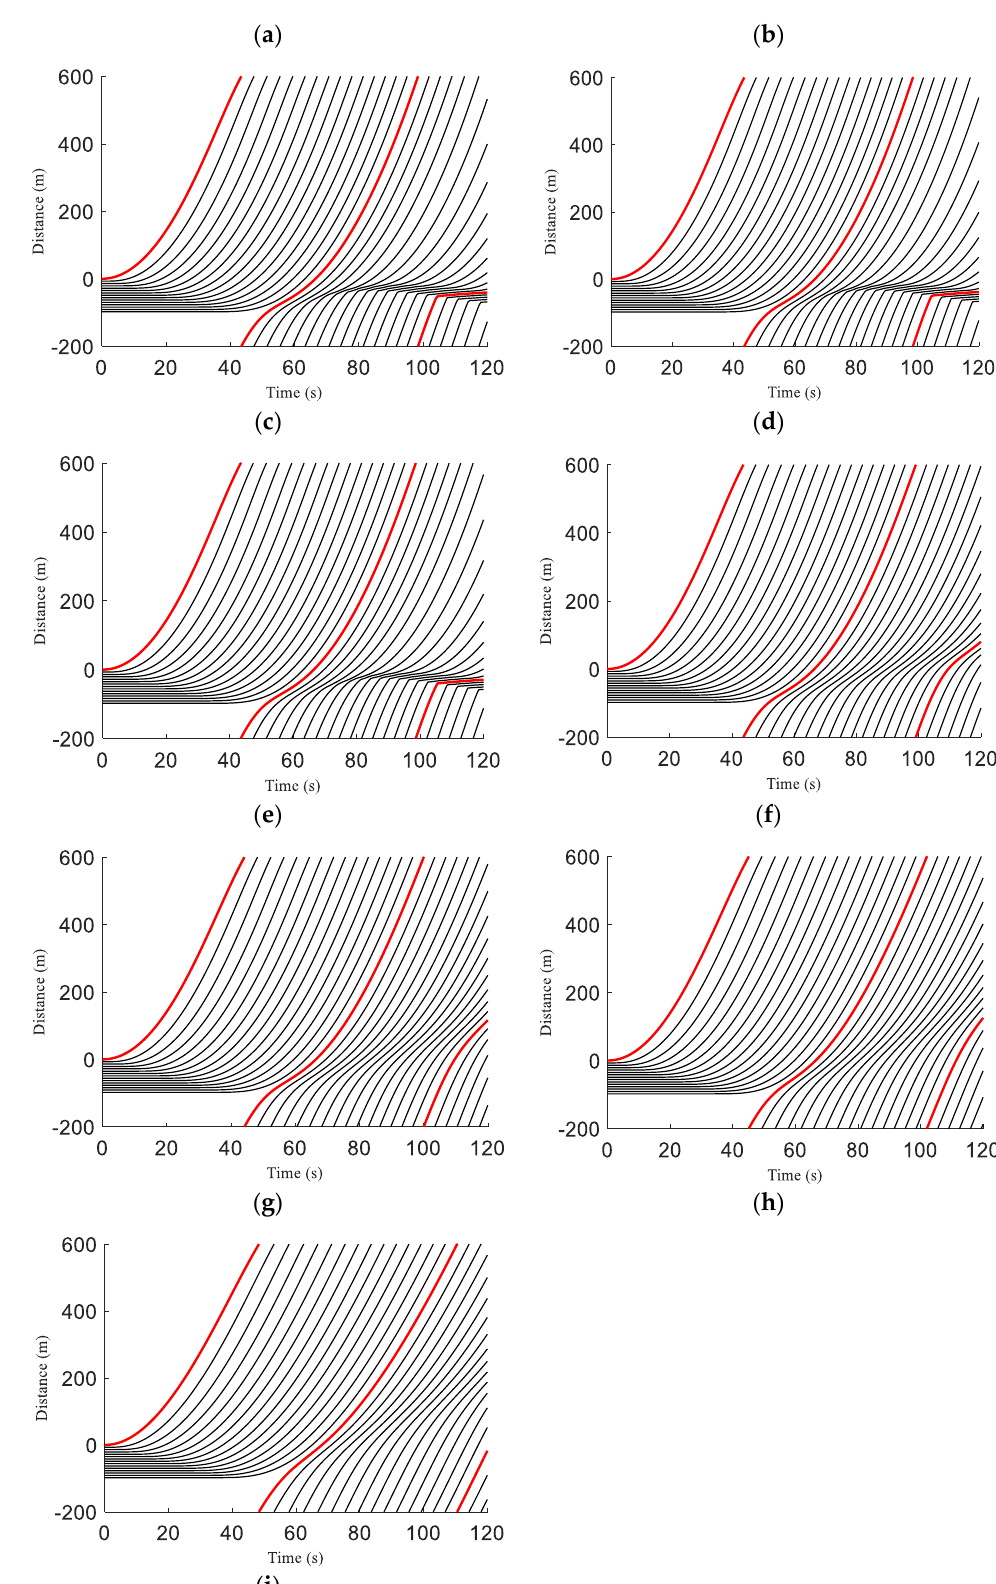
Figure 5. Time-space vehicle trajectories for the ID and proposed models over an 800 m circular road: ( a ) ID model, 𝛿 = 1 ; ( b ) ID model, 𝛿 = 4 ; ( c ) ID model, 𝛿 = 20 ; ( d ) proposed model, 𝛼 = 0 ; ( e ) proposed model, 𝛼 = 0.3 ; ( f ) proposed model, 𝛼 = 0.55 ; ( g ) proposed model, 𝛼 = 0.7 ; ( h ) proposed model, 𝛼 = 0.8 ; ( i ) proposed model, 𝛼 = 0.9 .